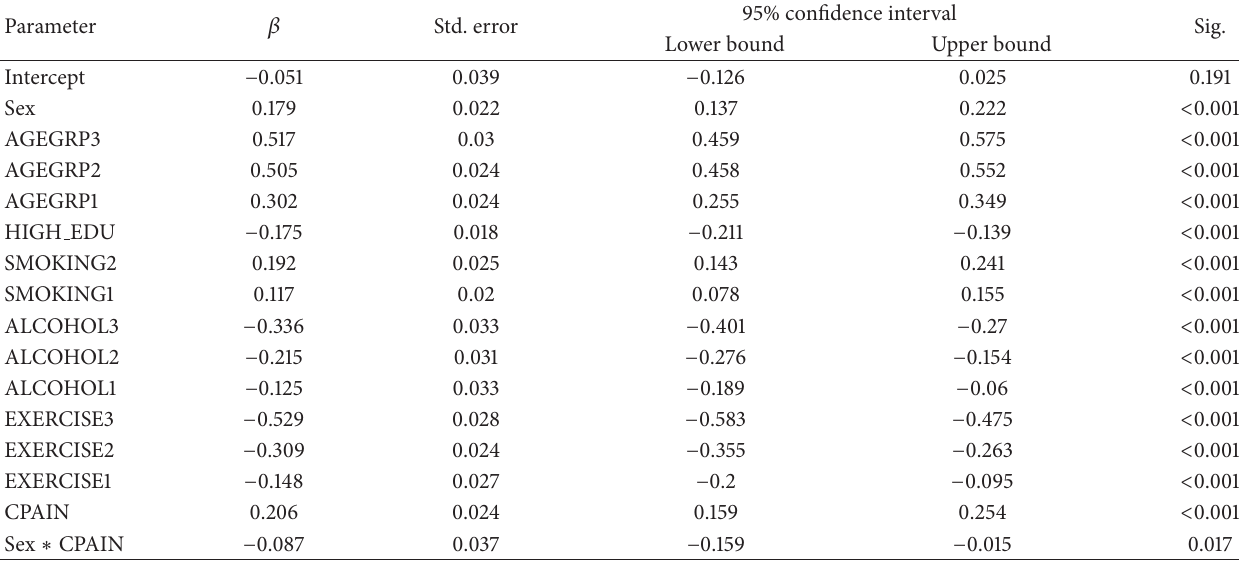
Table 4: Multivariable ANOVA of chronic pain and the risk factor